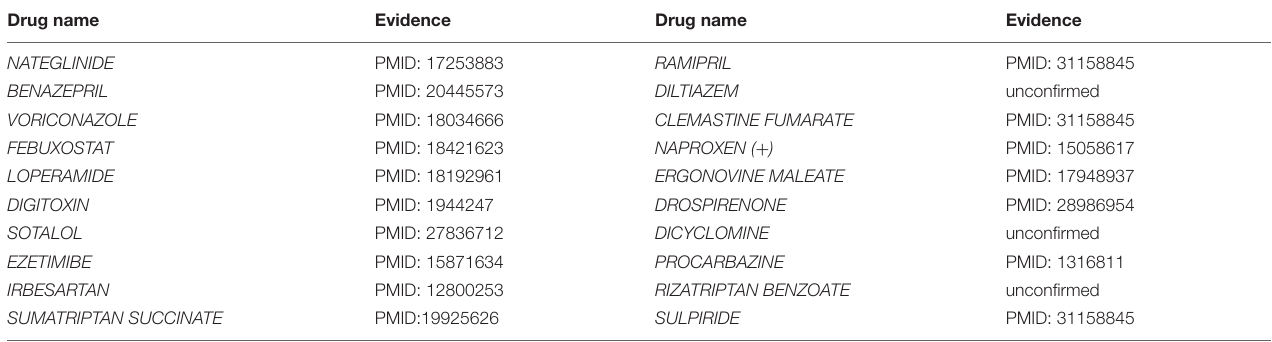
TABLE 4 | Top 20 predicted drugs associated with Bacteroides